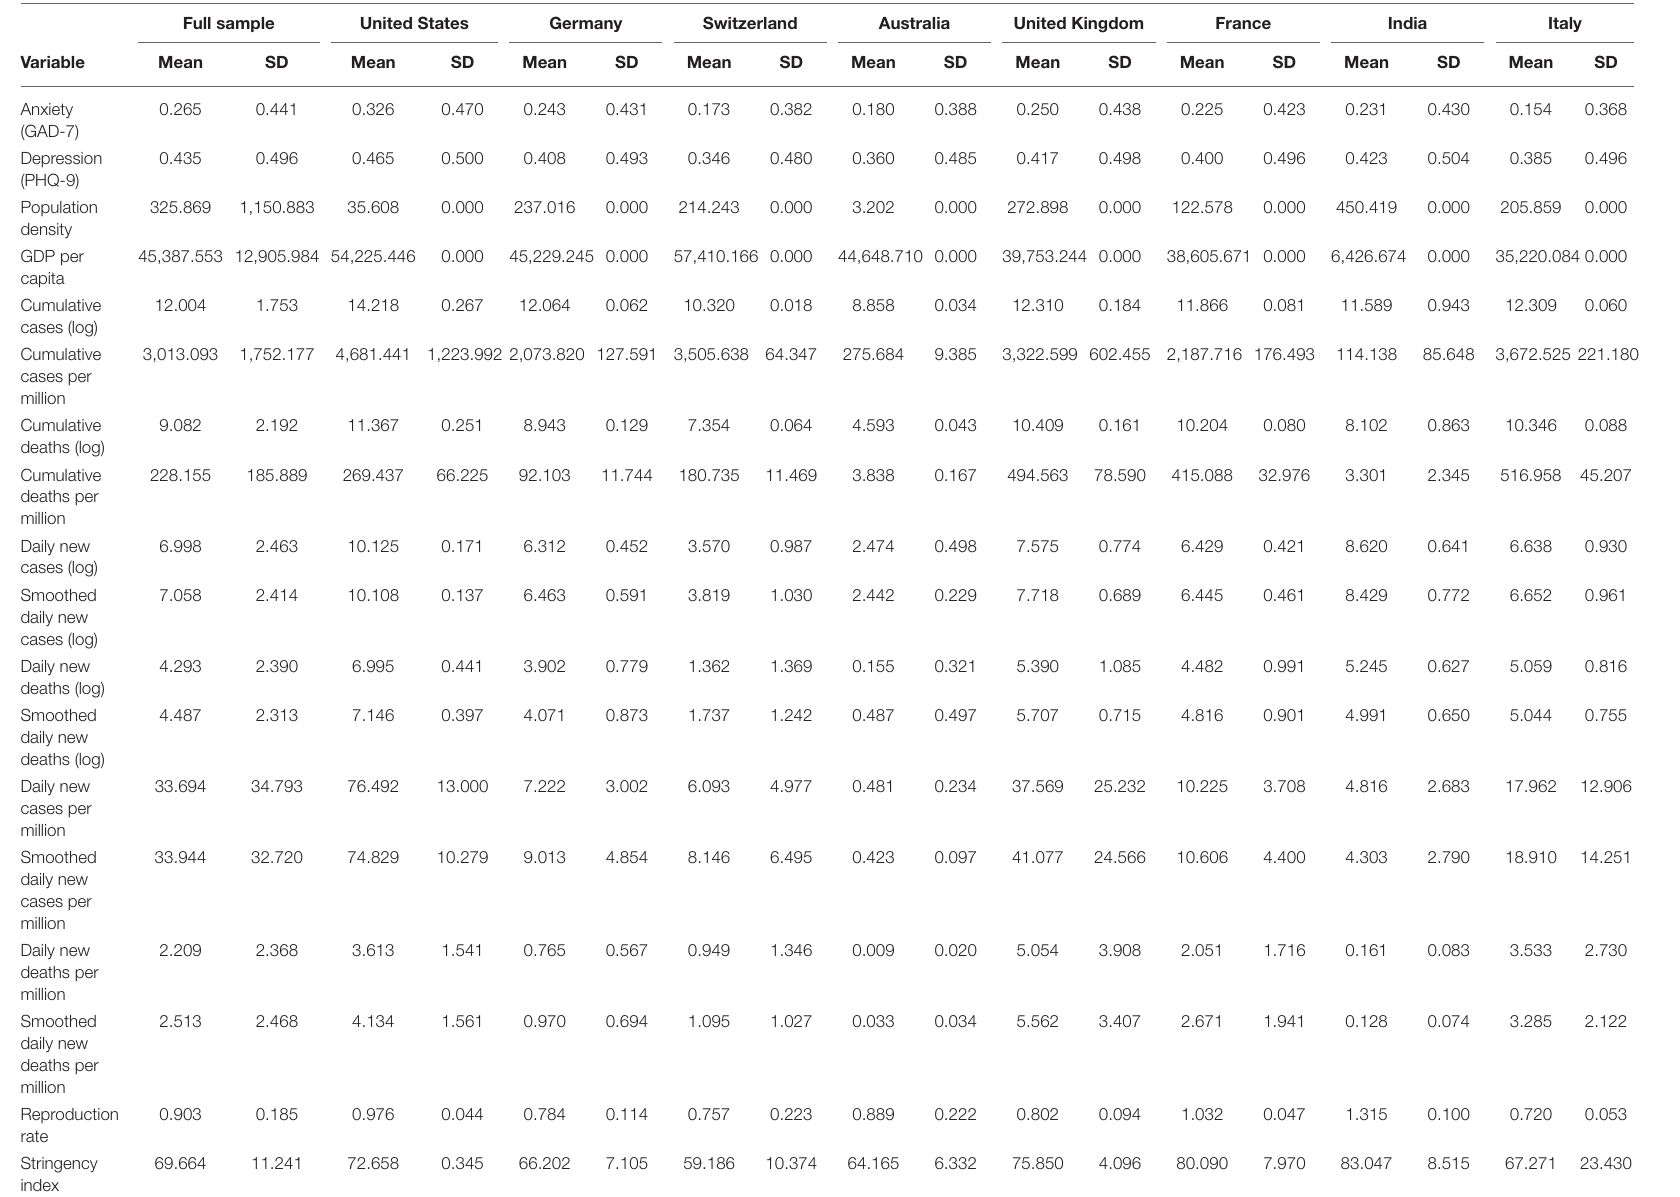
TABLE 2 | Descriptives for mental disorder symptoms and country-level COVID-19